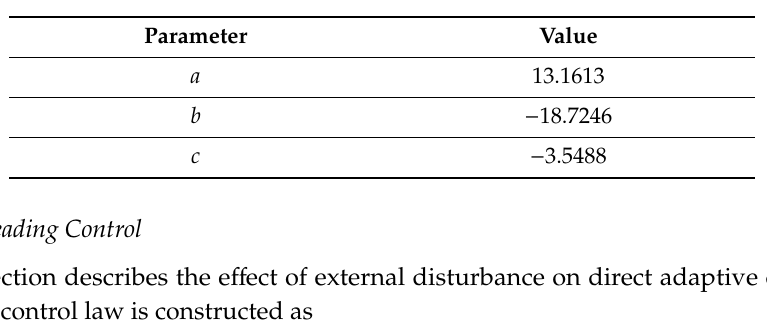
Table 3. Parameters for heading dynamics in